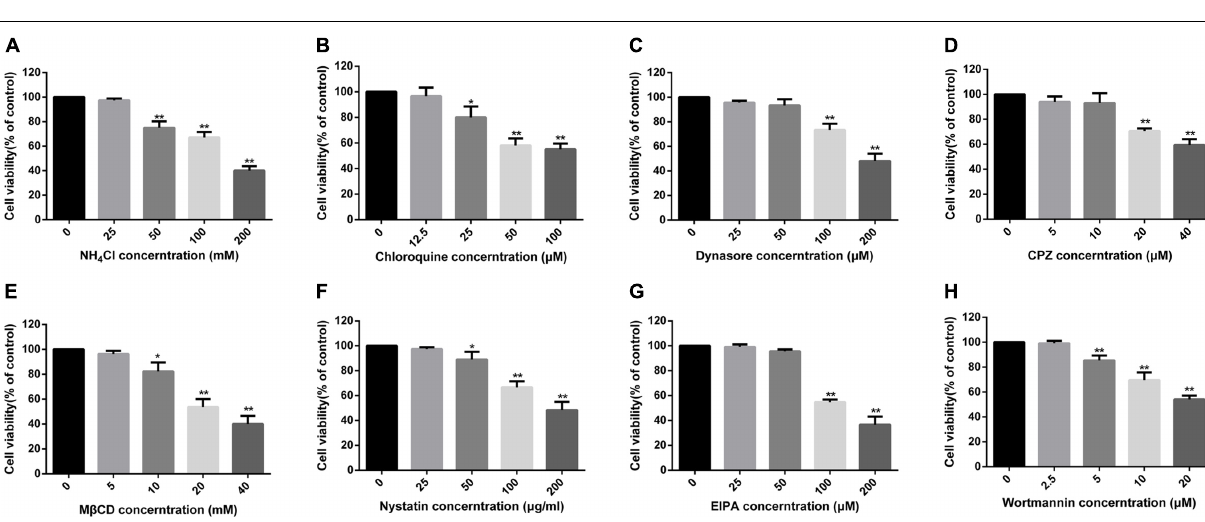
FIGURE 2 | MTT assays to determine the cytotoxicity of inhibitors in EECs. (A–H) All tested inhibitors were subjected to an MTT assay to evaluate their cytotoxicity toward EECs. Cells were exposed to the indicated concentrations of inhibitors for 24 h. The bars indicate the mean ± SD from three independent experiments. SD, standard deviation; ∗ P < 0.05; ∗∗ P <